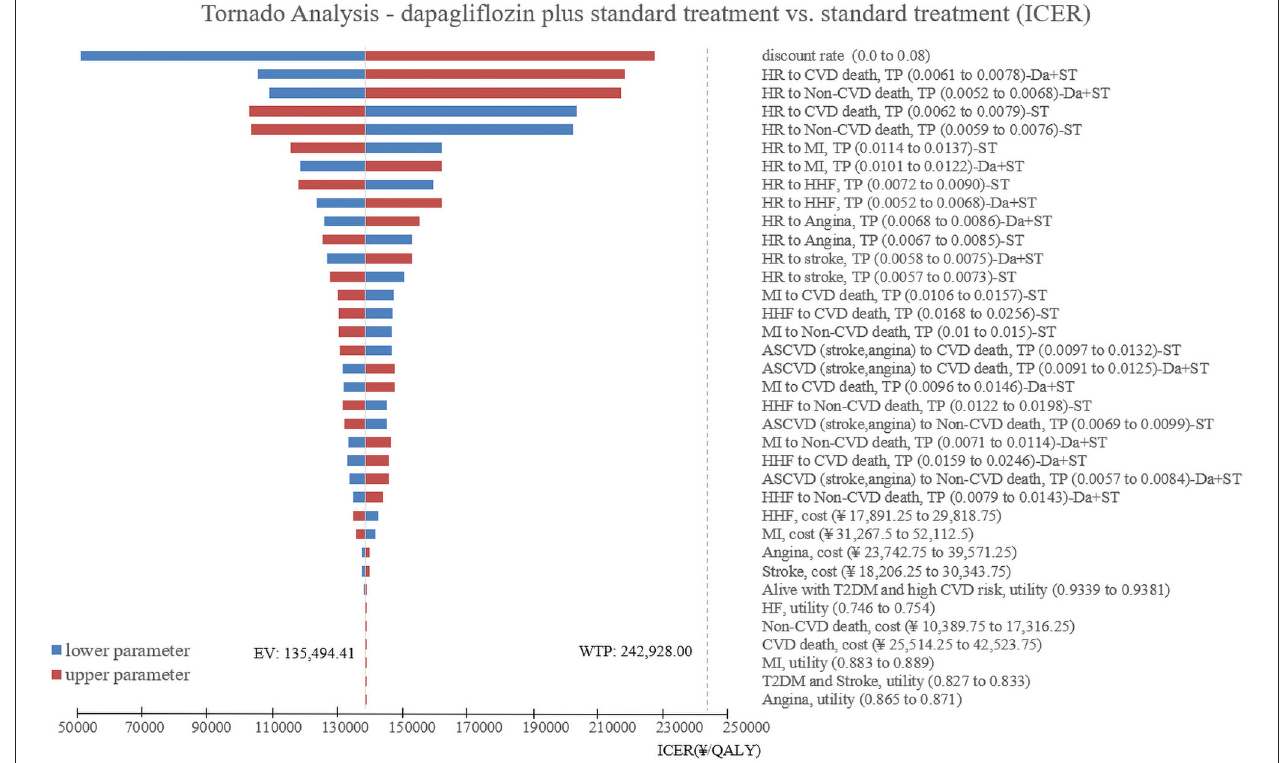
FIGURE 3 | Unidirectional sensitivity analysis tornado diagram comparing the dapagliflozin plus standard treatment with standard treatment in patients with T2DM and high risk of cardiovascular disease. HR, Alive with T2DM and high CVD risk; CVD, cardiovascular disease; TP, transition probabilities; Da, dapagliflozin; ST, standard treatment; MI, myocardial infarction; HHF, hospitalization for heart failure; ASCVD, arteriosclerotic cardiovascular